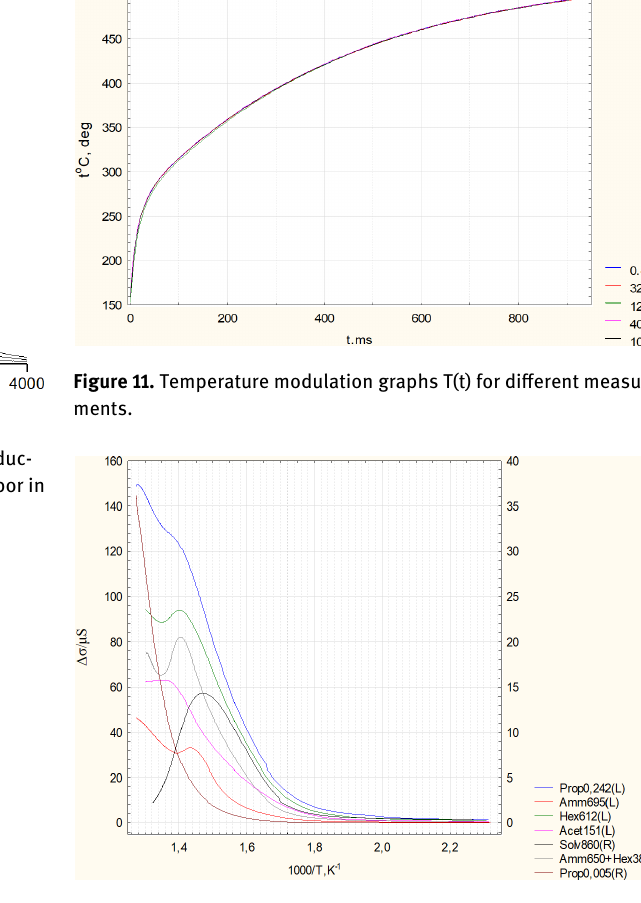
Figure 12. Different-shaped electrical conductivity signals as func- tions of the inverse absolute temperature ∆σ ( z = 1000/ T ( t )) for different adsorbents on ZnO-based